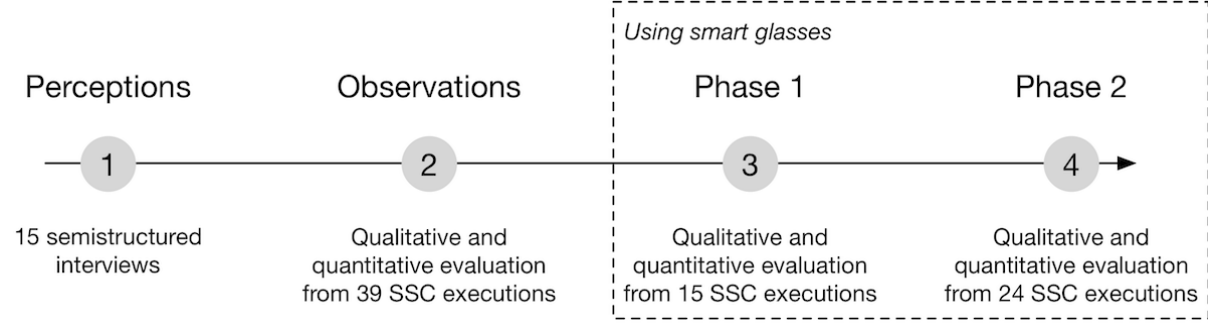
Figure 1. Data collection throughout the research process. SSC: surgical safety